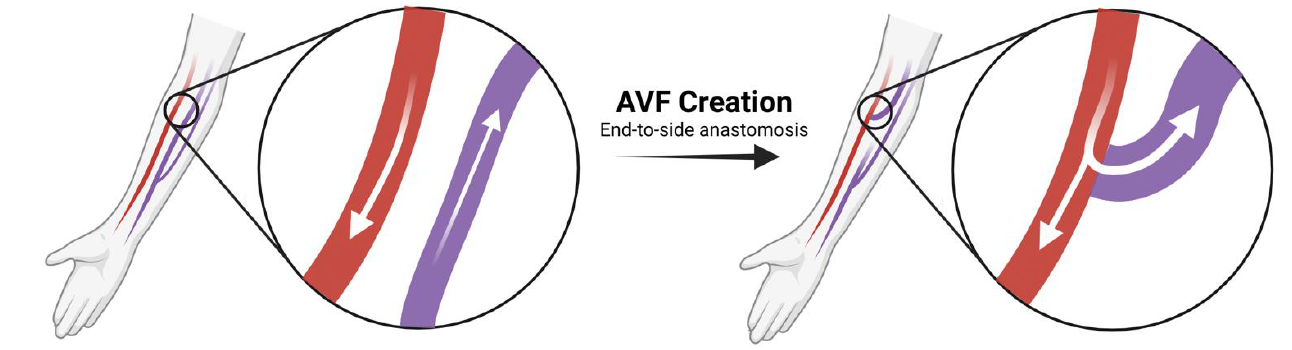
Figure 1. An end-to-side AVF anastomosis; immediately after surgery, the outflow vein (purple) experiences an increase in blood flow (Created with BioRender.com (accessed on 25 August 2022)). The increased WSS following AVF creation sets off a cascade of biochemical events.